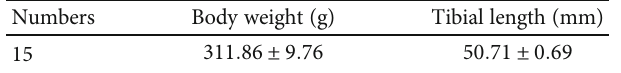
Table 1: Sample information ( mean ± SD